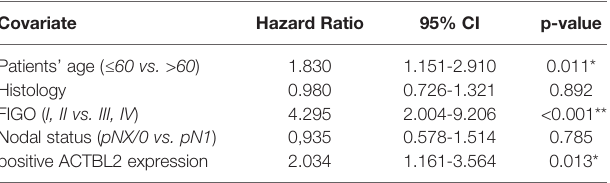
TABLE 3 | Multivariate analysis. Covariate Hazard Ratio 95% CI